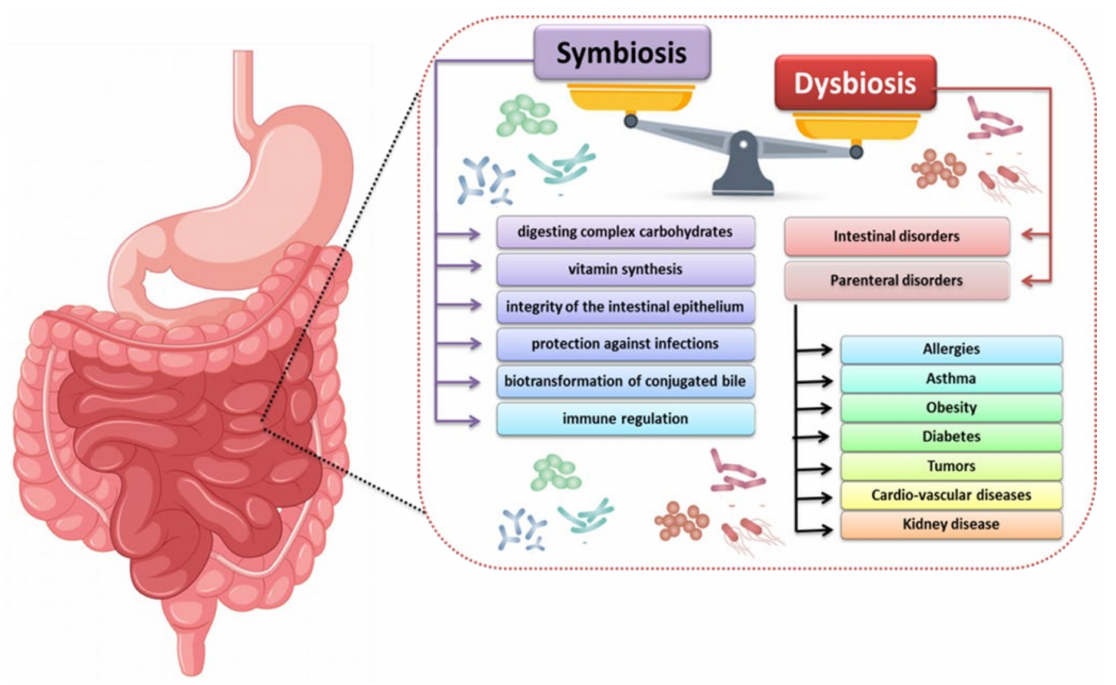
Figure 2. The importance of symbiosis and dysbiosis in the human intestinal microbiota in maintaining homeostasis and pathological changes (based on